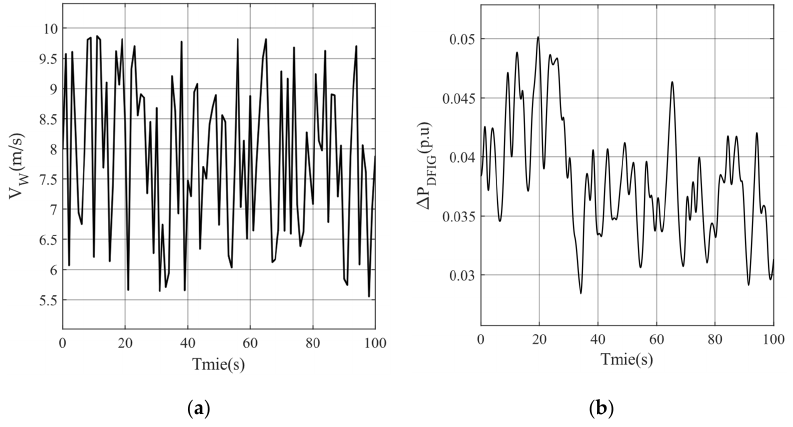
Energies 2023 , 16 , x FOR PEER REVIEW Figure 8. The variation of ( a ) random wind speed